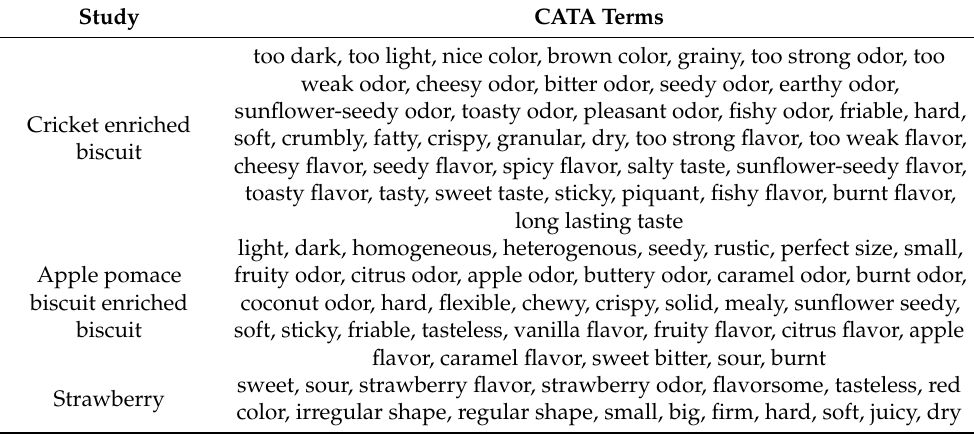
Table 1. Attributes evaluated by consumers using CATA questions for sensory characterization of different product categories in the four studies included in this